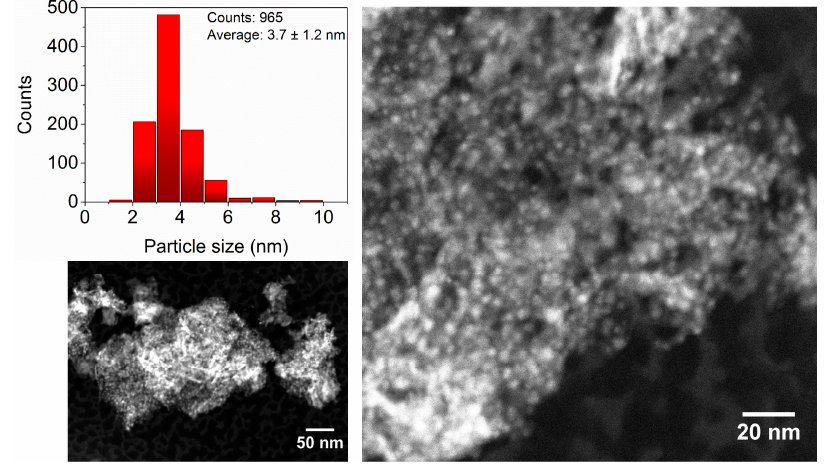
Figure 1. Scanning transmission electron microscopy (STEM) images and particle size distribution (top left) of the 10 wt % Ni/Al 2 O 3 catalyst prepared by homogeneous deposition-precipitation.